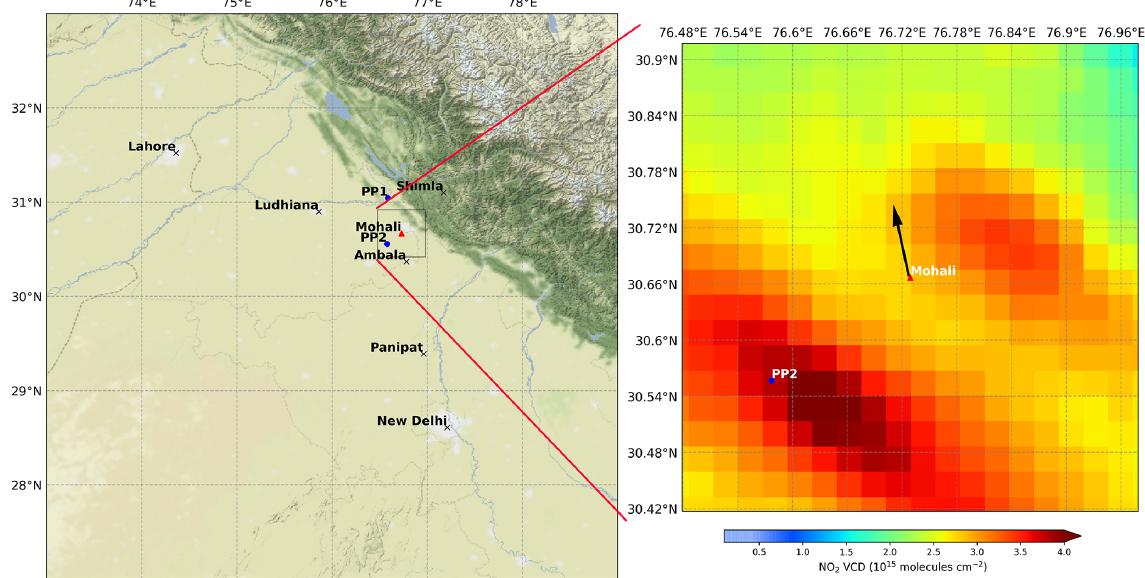
Figure 1. Left: terrain map showing the location of Mohali (red triangle) in North India, along with major cities (crosses) and two major thermal power plants near Mohali (blue circles: PP1 – Guru Gobind Singh super thermal power plant; PP2 – Larsen & Toubro super thermal power plant (NPL), Rajpura) and province boundaries. Right: mean tropospheric NO 2 VCD measured by TROPOMI overlaid on the terrain map of a 0.5 ◦ × 0.5 ◦ box around Mohali (shown in the left panel) for the period December 2017–October 2018. The black arrow indicates the viewing direction of the MAX-DOAS instrument. Terrain maps are adapted from Stamen (http://maps.stamen.com/terrain, last